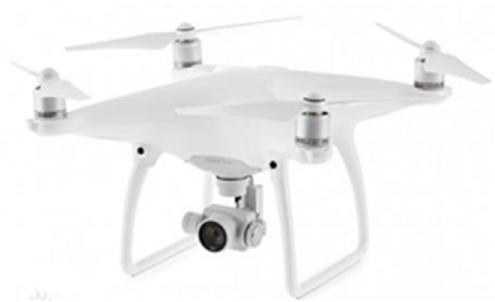
Figure 2. The DJI PHANTOM 4.